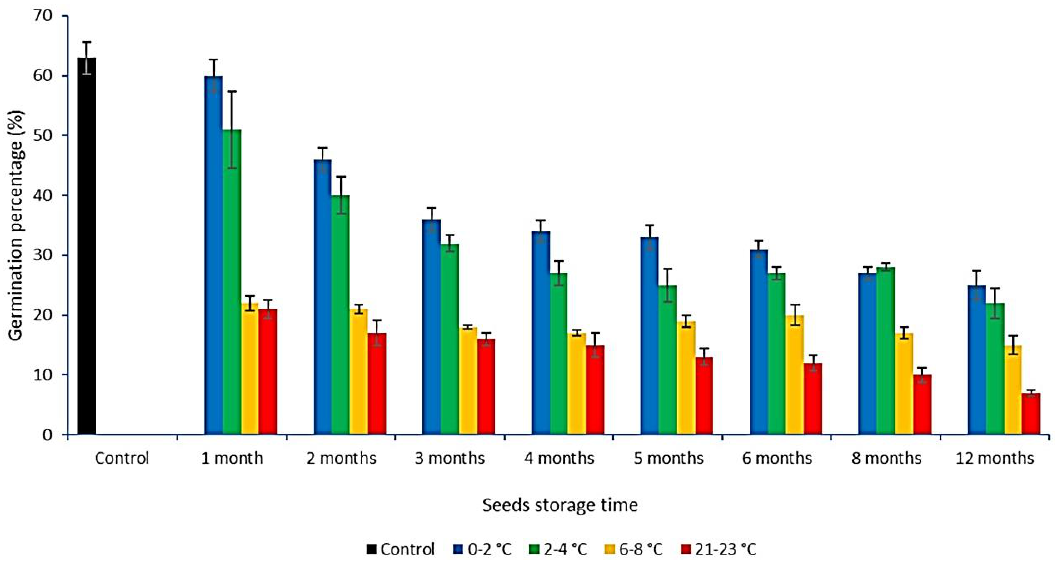
Figure 6. Average germination percentage of C. calyculata seeds stored at various temperatures for 1–6, 8, and 12 months. Vertical bars indicate a standard error (±SE).